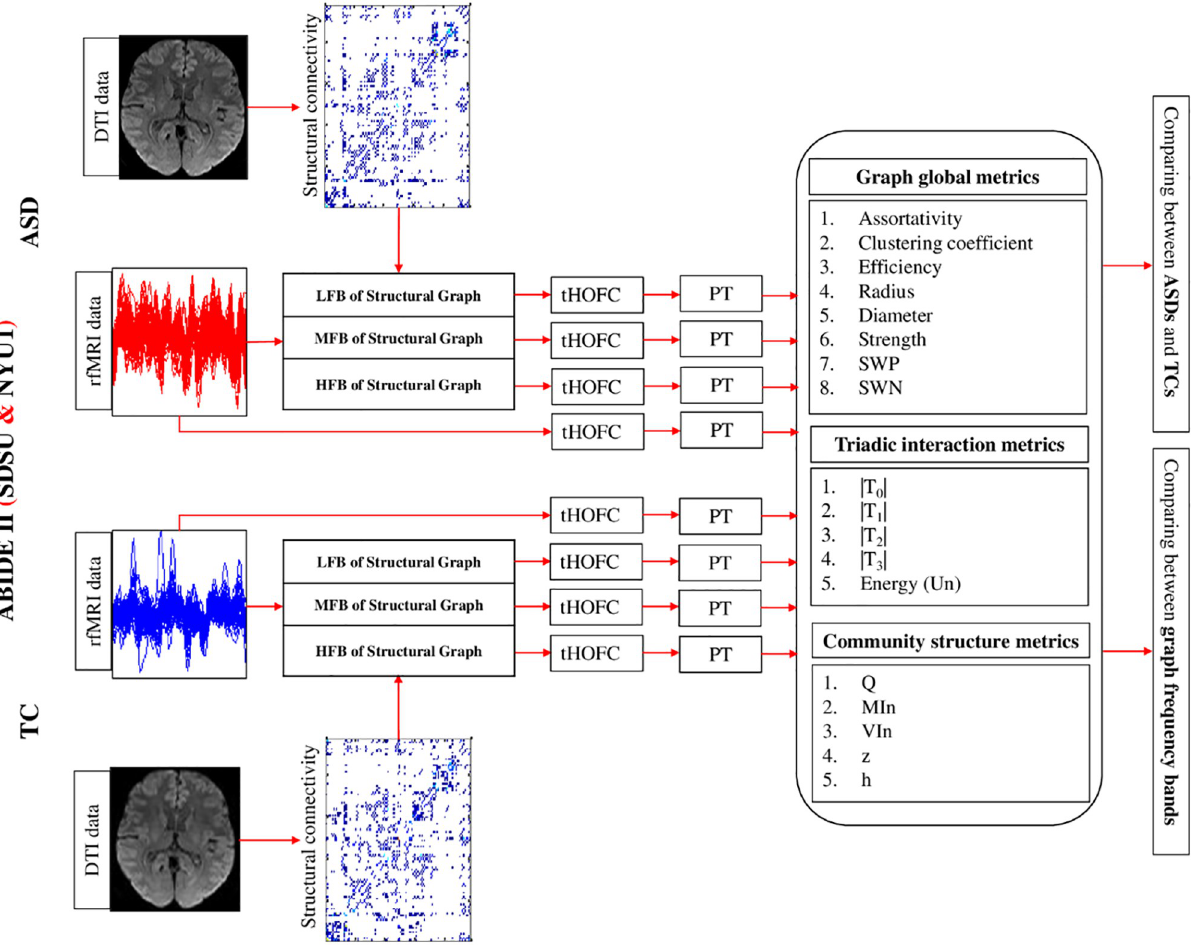
Fig 1. Overview of pipeline steps and study design. The rfMRI and DTI data of SDSU and NYU1 datasets of ABIDE II were used in this study. Using the DTI data, the structural connectivity and frequency bands of the structural graph were computed for each subject. The rfMRI data was passed through the structural graph’s LFB, MFB, and HFB filters. The FC matrix was computed for filtered and unfiltered data through tHOFC method. Thus, four FC matrices were calculated for each subject. Then, proportional thresholding was applied on FC matrices to remove weak connections. For each FC matrix, the global metrics of the graph and metrics of triadic interactions were computed. Finally, these metrics were compared between ASD and TC groups. Also, for a given group, the metrics results in the LFB, MFB, and HFB were compared. The results of Community structure metrics are provided in the S1